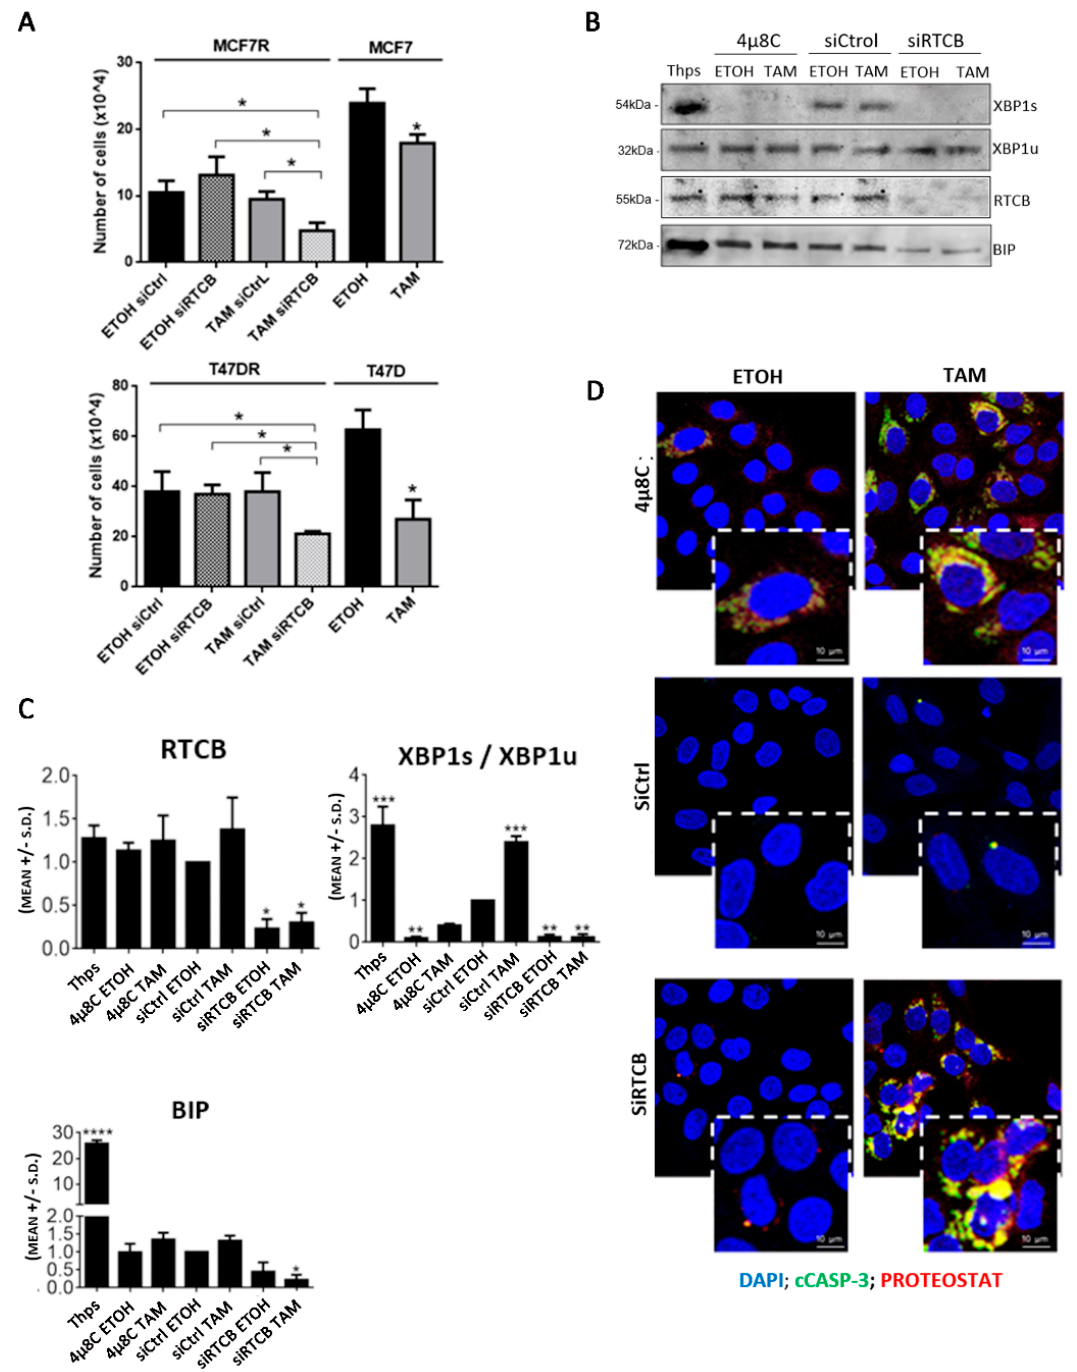
Figure 4. Inhibition of RTCB expression with siRNAs restores sensitivity to TAM in antiestrogen-resistant cell lines. ( A ) Knock-down of RTCB with siRNAs in MCF-7R and T-47DR cells for 24 h prior treatment with 500 nM TAM + siRNAs for 3 days. Comparisons for the same cell line vs. other treatments, * p < 0.05. Experiments are representative of three. ( B ) The effect of RTCB knock-down on XBP1s, XBP1u and BiP protein levels in MCF-7R cells was assessed and compared side-by-side to the effect of the IRE1 α activator Thapsigargin (Thps; 0.5 µM) and inhibitor 4µ8C (25 µM). ( C ) Quantification of results shown in ( B ). Comparisons vs. siCtrl ETOH ***: p < 0.001, **: p < 0.01; *: p < 0.05, non-parametric t test. ( D ) Aggresome and cleaved CASP3 (cCASP-3) colocalization in cells treated for 24 h with 500nM TAM in combination with siRNA for RTCB or 25 µM 4µ8C.